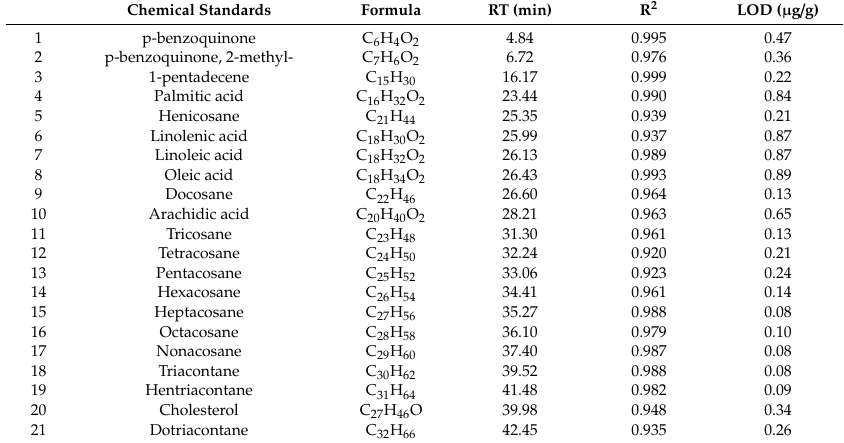
RT is retention time, LOD is the limit of detection, and R 2 is a linear regression coe ffi cient. Based on solvent weight, the concentration of standards presents as µ g /